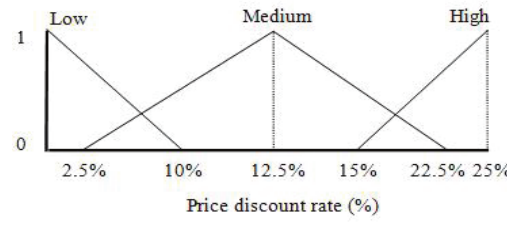
Fig. 3 Membership function for price discount rate.